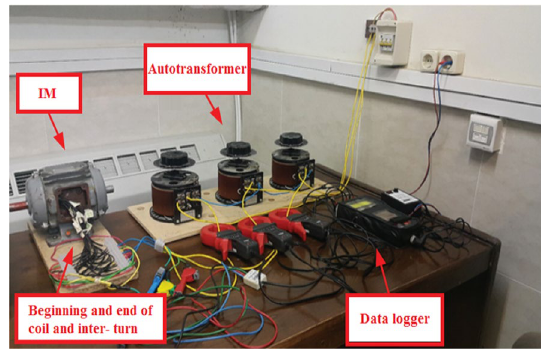
Fig. 15 Implemented experimental platform for detecting SITF